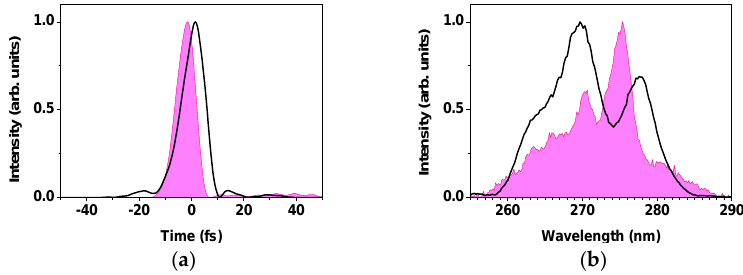
Figure 8. ( a ) Temporal; and ( b ) spectral intensity profiles of the DUV pulses generated by the scheme (i) (solid area) and scheme (ii) (solid line), respectively.